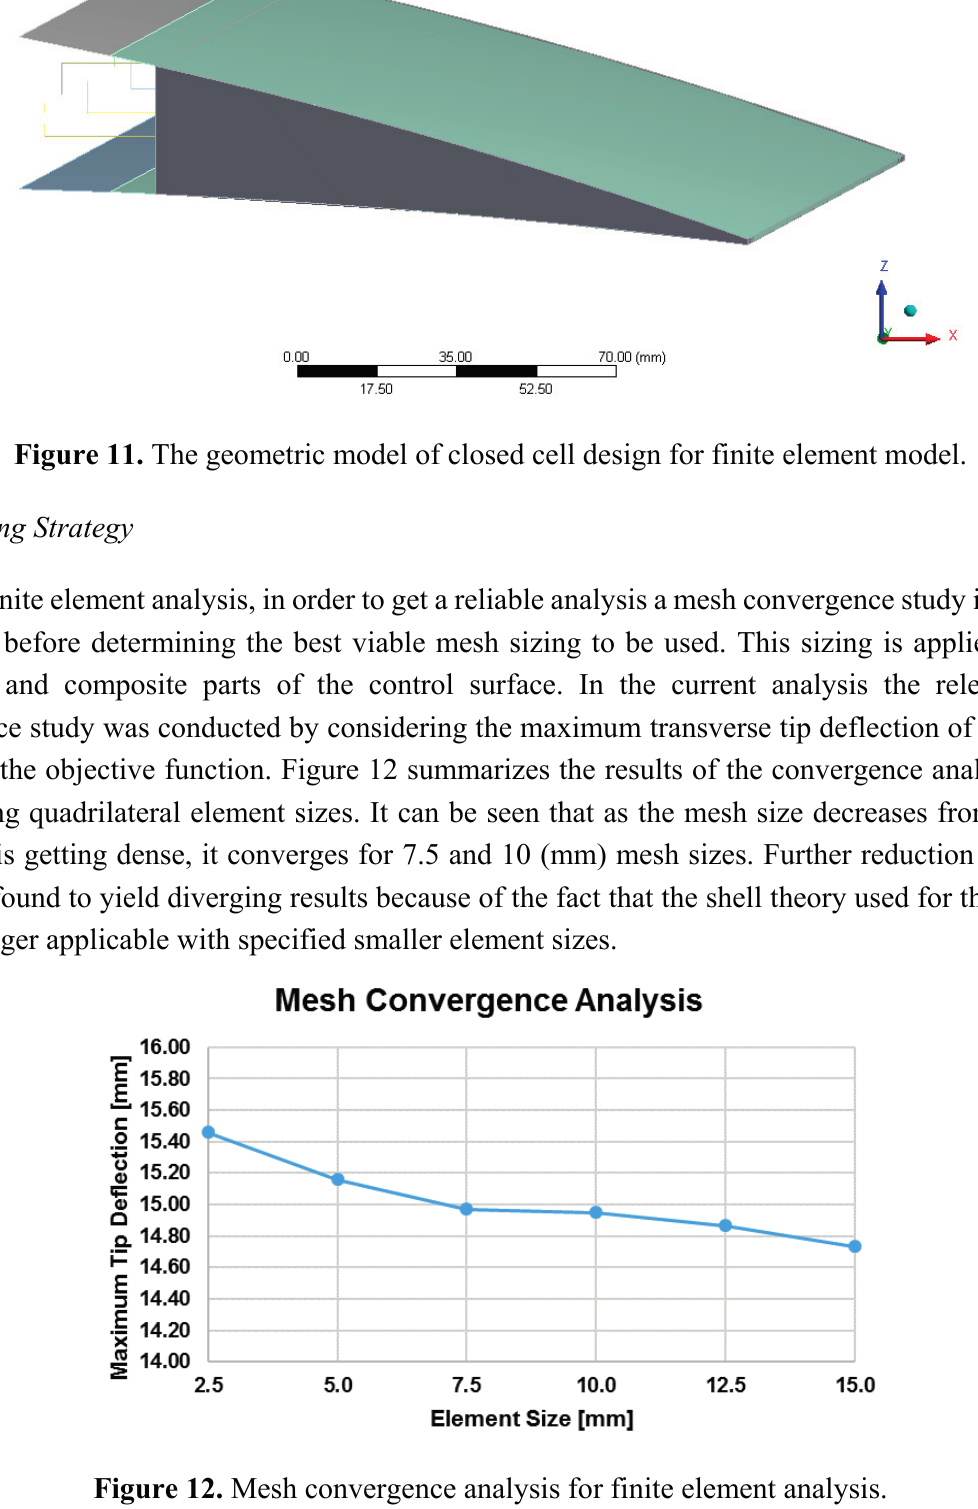
Figure 12. Mesh convergence analysis for finite element